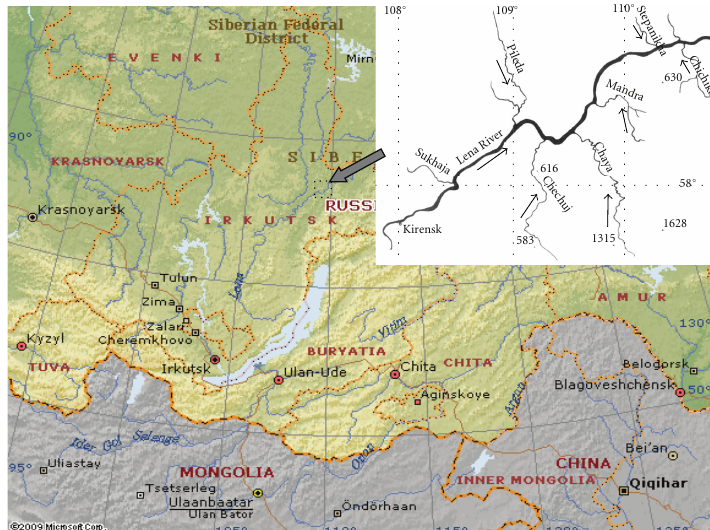
Figure 1: Location of the study region (left) and schematic map of the sampling area (right).